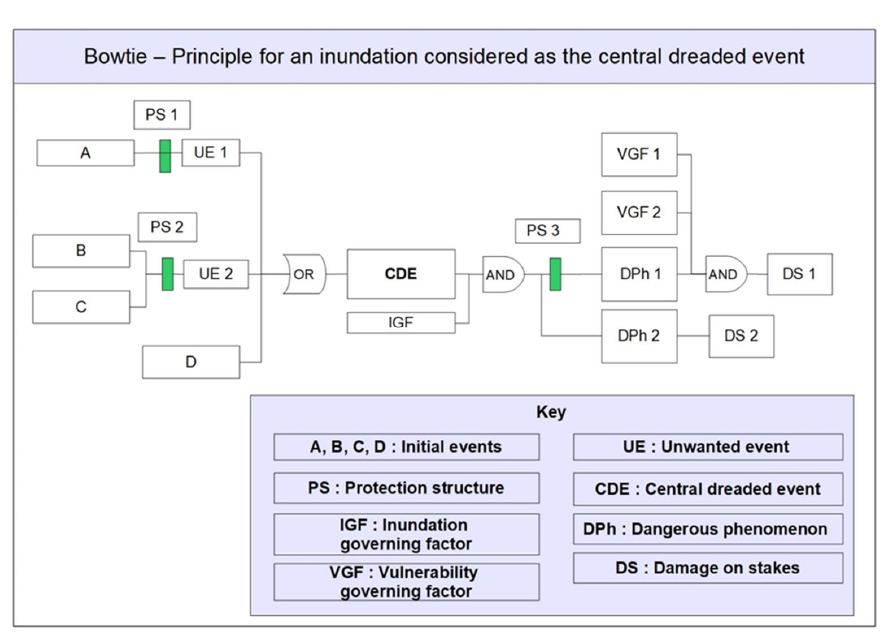
Figure 11. Generic representation of a bowtie tree.